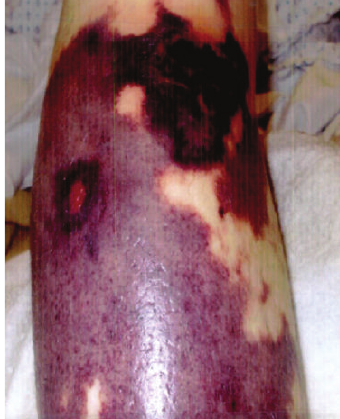
Figure 3: Extensive involvement of the leg.